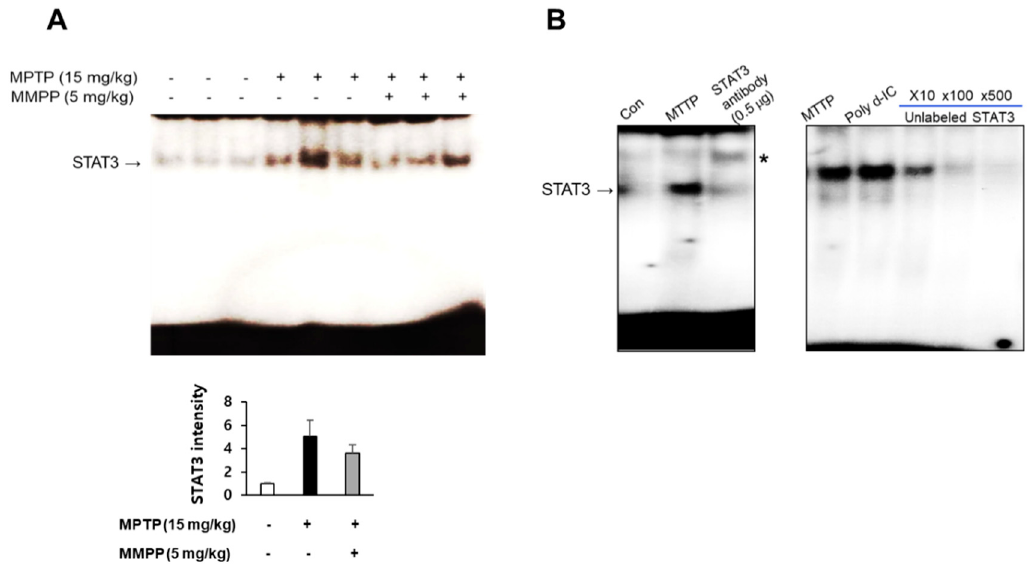
Figure 5. MMPP reduces translocation of STAT3. The protective e ff ects of MMPP against inflammatory signaling pathways were measured by EMSA. MMPP inhibited MPTP-induced translocation of STAT3 protein to the nucleus in brain tissue, as determined ( A ). Values are presented as mean ± SD from three mice. Specificity of STAT3 DNA binding activity. * indicates super shift of STAT3 ( B , left panel). Noncompetitive (Poly d-IC) and competitive (with unlabeled oligonucleotide of STAT3) assays ( B , right panel).